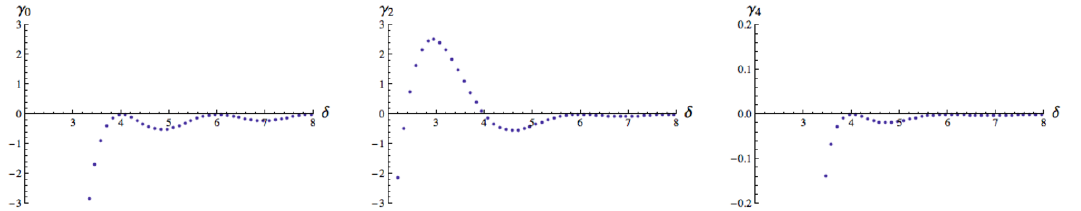
Figure 3 . Contribution to the anomalous dimension (cid:13) 0 ; 0 , (cid:13) 0 ; 2 and (cid:13) 0 ; 4 from the exchange of an intermediate operator of spin two, in units of the positive OPE